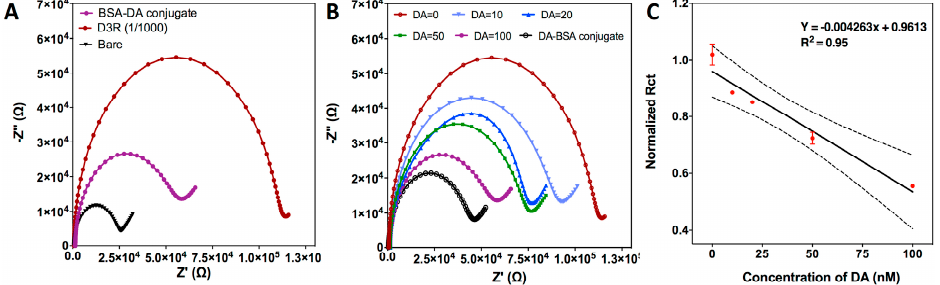
Figure 2. Characterization of EC biosensor for indirect DA detection. ( A ) Nyquist plots drawn for different stages of functionalization of CSPE; bare, BSA-DA conjugate-immobilized and D3R (dilution: 1/1000). ( B ) Indirect detection of DA at various concentration; 0, 10, 20, 50, 100 nM. Color code: D3R: bordeaux; bare: black; BSA-DA conjugate: purple. ( C ) Calibration curve of EC biosensor for indirect DA detection based on normalized R ct values. Each value represents the mean and SD of five measurements.